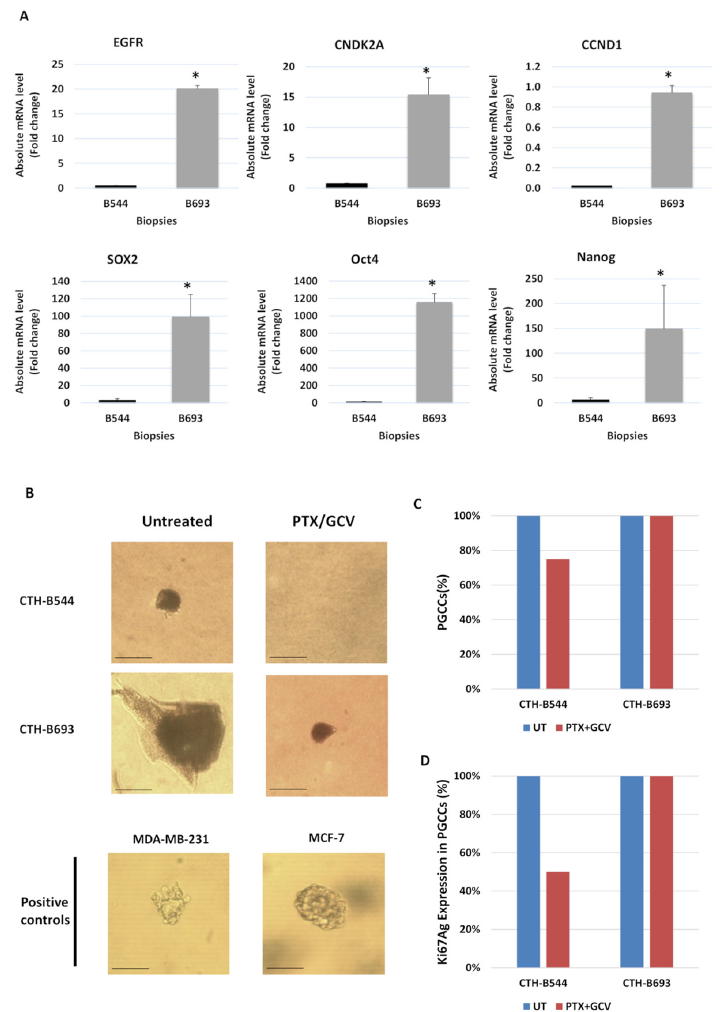
Figure 8. Distinct responses of CTH cells to paclitaxel/ganciclovir (PTX/GCV) treatment in vitro recapitulates distinct TNBC molecular signatures in vivo. ( A ) EGFR, CNDK2A, CCND1, SOX2, Oct4, and Nanog mRNA expression was measured by RT-qPCR in TNBC biopsies B544 and B693. Histograms represent the mean ± SD of three independent experiments. * p ≤ 0.05, determined by Mann–Whitney U test. ( B ) Soft agar seeded with CTH-B544 and CTH-B693 cells treated with PTX (20 nM)/GCV (20 μ M) combination therapy. Untreated cells were used as negative controls; MCF7 and MDA-MB231 cells were used as positive controls. Magnification ×200, scale bar 100 μ m. ( C ) Propidium iodide (PI) staining for detection of PGCCs in untreated and treated CTH cells by FACS analysis. ( D ) Ki67 Ag expression in PGGCs of untreated and treated CTH cells.